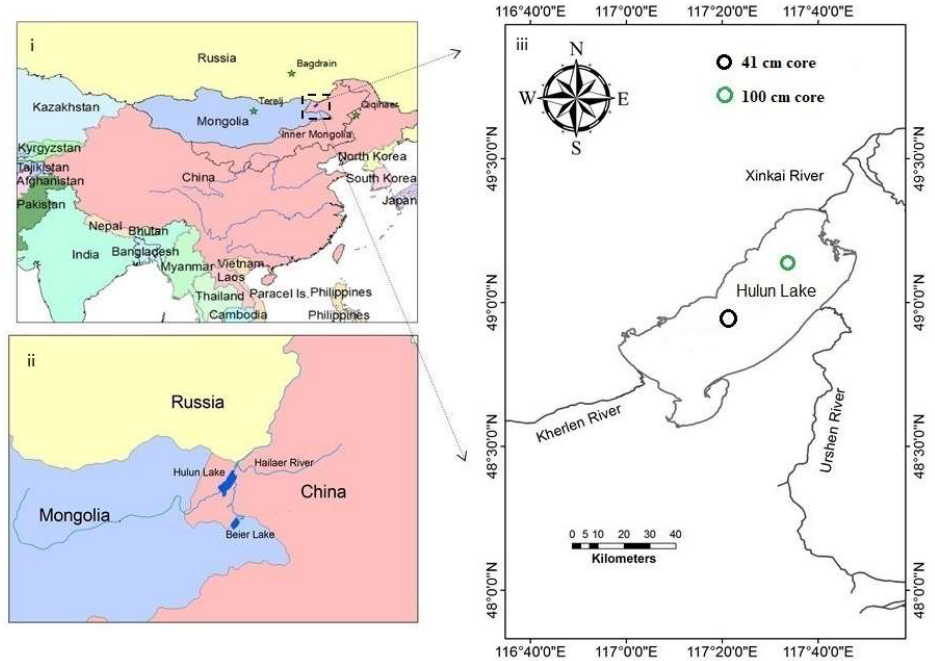
Figure 1. Location of study area: ( i ) study area on a country-scale map; ( ii ) whole Hulun Lake basin; ( iii ) core sampling site (black circle indicates the location of the 41 cm core of this study, while the green circle indicates the location of the 100 cm core sampled by Liang (2017) from the Inner Mongolia water environment group [20]).